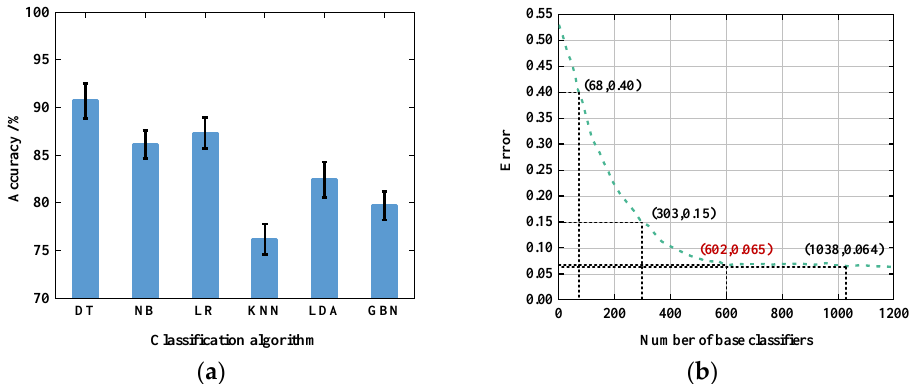
Figure 15. The impact of the type and number of base classifiers: ( a ) impact of the base classifier type; ( b ) impact of the number of base classifiers.